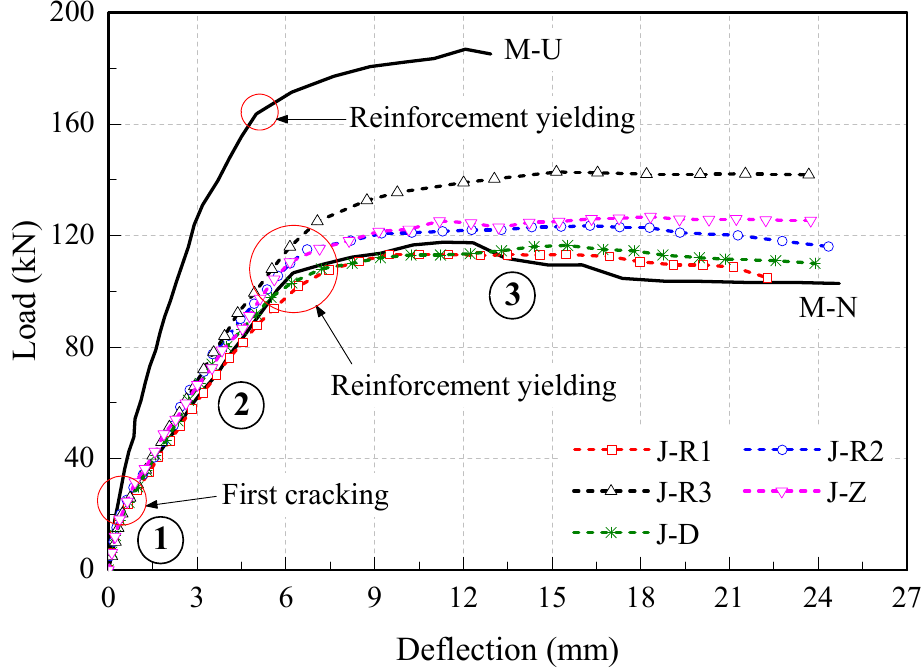
Figure 4. Load versus midspan deflection of the test specimens.